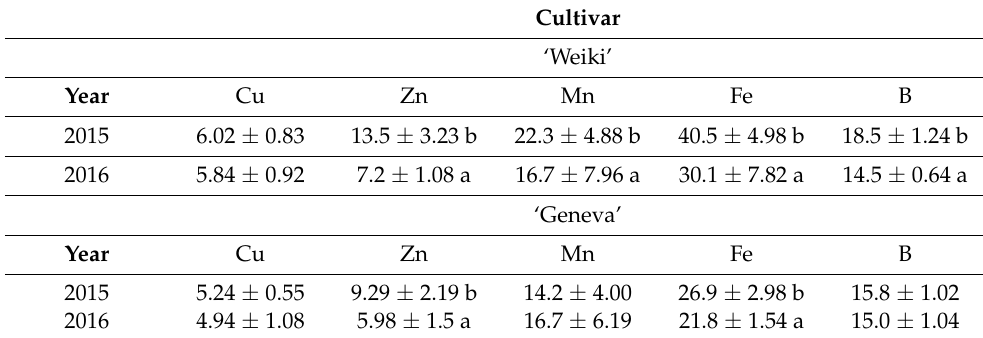
Table 7. Fruit micronutrient concentration (mg kg − 1 DW): cultivar and growing season effects.